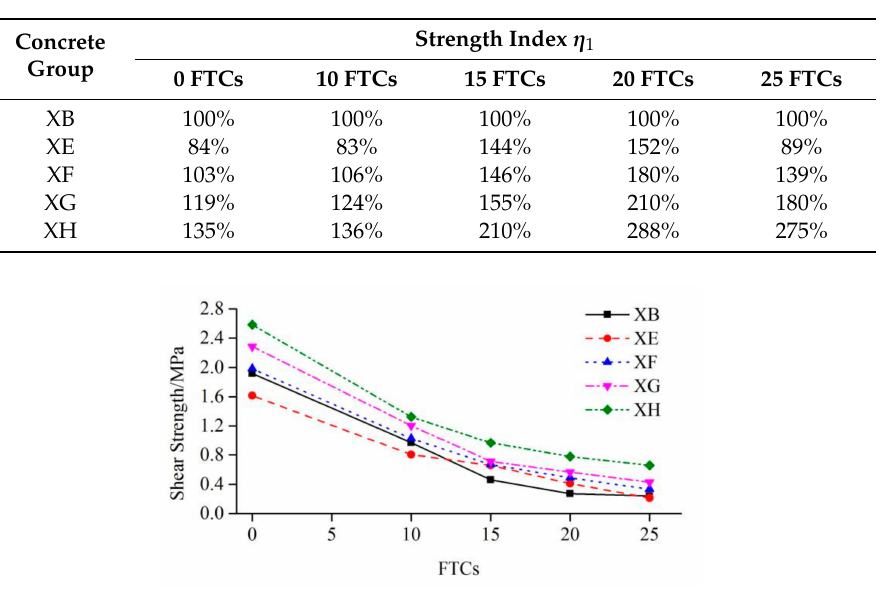
Table 3. The values of η 1 .